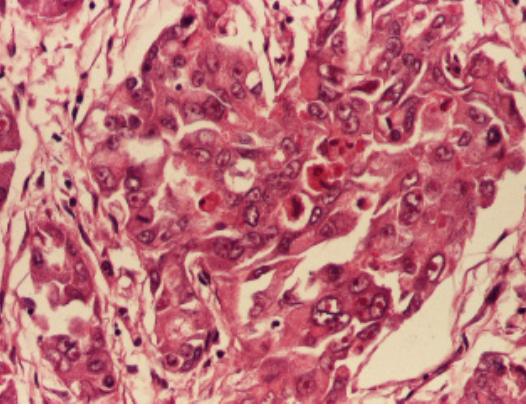
Figure 6. Large tumor cells with marked cyto-nuclear pleomorphism and atypical mitosis, HEx 200.